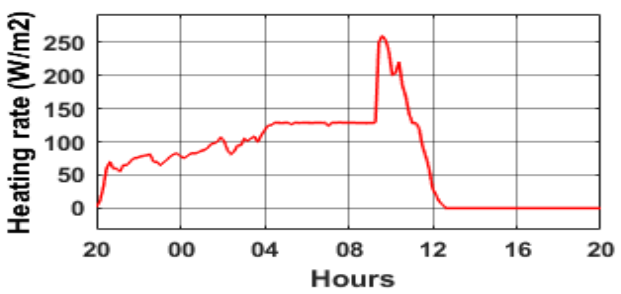
Figure 24. Heating rate of the greenhouse.